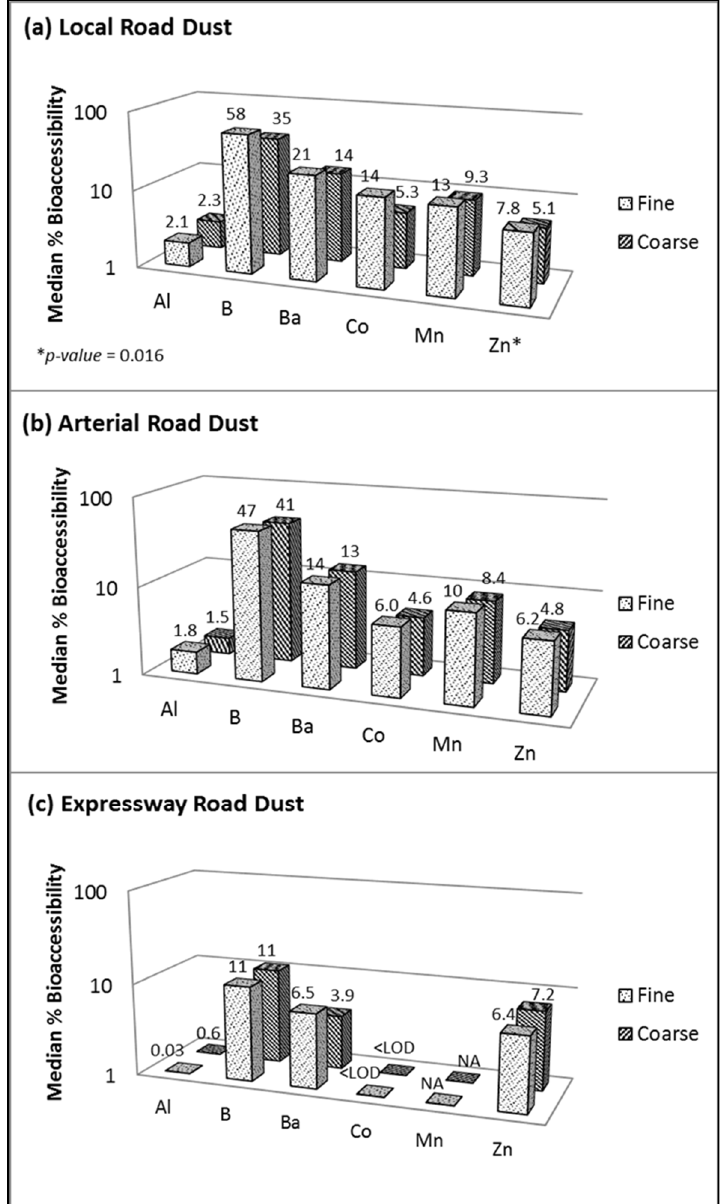
Figure 4. Element bioaccessibility in fine versus coarse fractions of resuspended road dust when using Gamble solution (pH 7.2) for ( a ) local road, ( b ) arterial road and ( c ) expressway dust. Fine = <1.8 µm and coarse = 1.8–10 µm; Mn not reportable for ( c ) expressway.